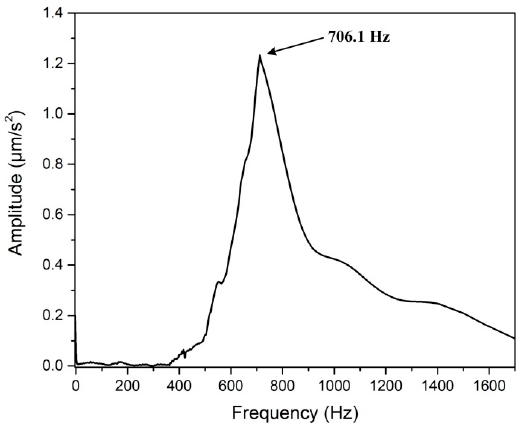
Figure 13. Experimental results of the first resonance frequency tests.